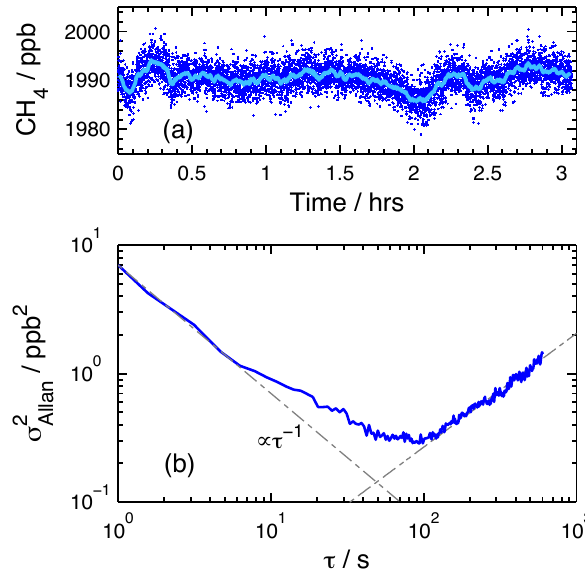
Fig. 3. (a) Time series of a CH 4 = 1986 . 8 ppb gas-standard mea- surement in the laboratory. The thick line indicates a 80 s moving average. (b) Allan variance versus integration time of the time se- ries. The maximum stability time is around 80 s, where the preci- sion of the instrument is σ ∼ 0 . 6 ppb. Fig. 4. (a) Sequential measurement of two known calibration gas mixtures (1986.8 ppb, 1794.3 ppb) yielded an accuracy within plot a precision of σ Allan = 2 . 65 ppb, which corresponds to a the 60 minute measurement time of 6.5 ppb ( < 0 . 5% ). Horizon- fractional absorbance of 5 . 1 × 10 − 10 cm − 1 . The FGGA in- tal lines indicate the mixing ratio of the respective gas standard flight data are reported as 10 s averages, where the preci- as determined by gas chromatography. (b) Difference of average sion in the laboratory is determined to be σ Allan = 0 . 96 FGGA measurements to gas standard mixing ratio ( (cid:5) 1986.8 ppb; (cid:3) 1794.3 ppb). The accuracy is mostly determined by instrumental drift.